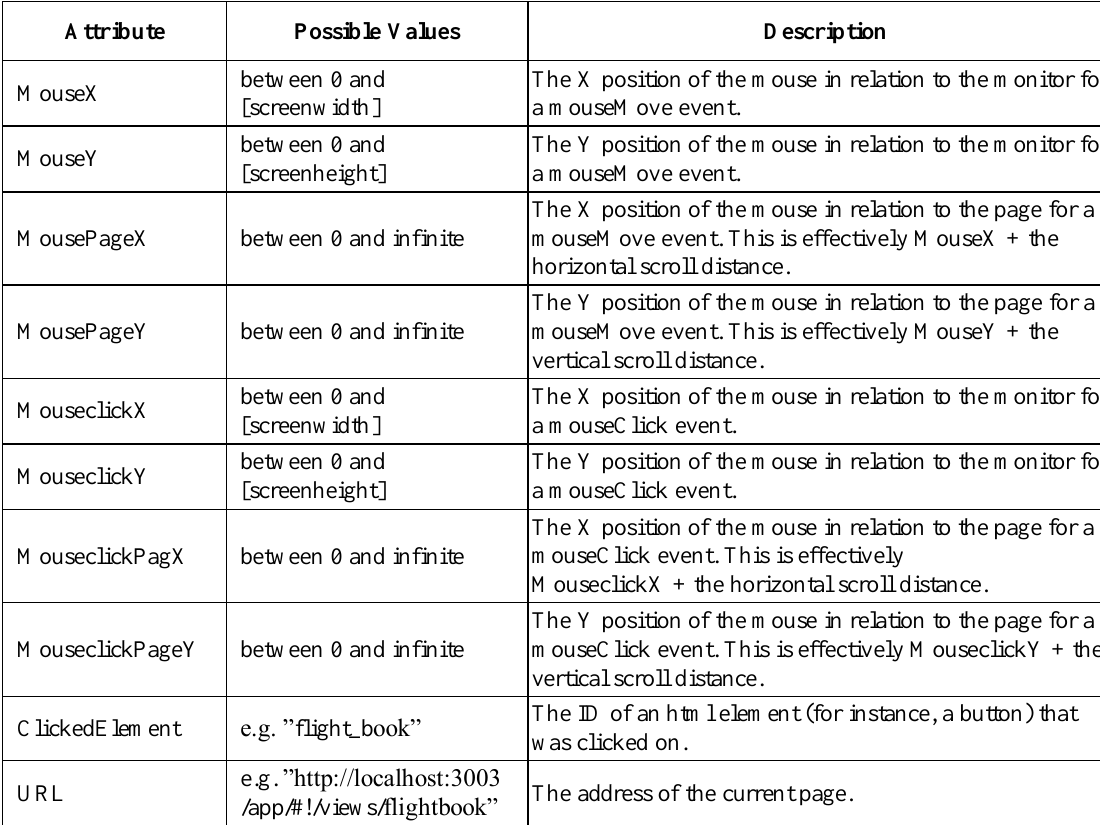
Table 4. Metadata from the